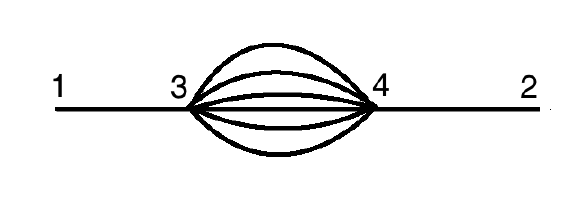
Figure 4 . Gluing in one more propagator connecting vertices 3 and 4 in (cid:12)gure 1, we arrive at this diagram, with q 1 propagators connecting points 3 and 4. It is essentially the same diagram (cid:0) that one encounters in the Schwinger-Dyson equation that determines the two-point function of the model for large N